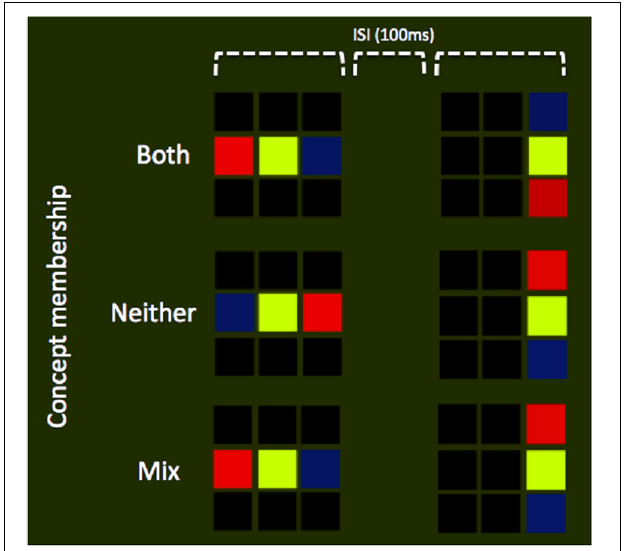
FIGURE 2 | Experimental design. Schematic illustration of display sequences, in which all trials consisted of two stimulus presentations each with a duration of 1s. Separating these two presentations was a blank screen, ISI interval of 100ms. Participants were instructed to respond on the basis of the number of patterns that matched the target concept. Three possible combinations are illustrated in the panel above: (1) Both stimuli are drawn form the target concept set (top row; see Figure 1 , for the rules on concept membership), (2) Neither stimuli are drawn from the